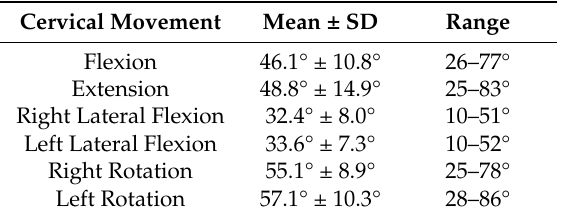
Table 5. Descriptive statistics for CROM ( n = 55, healthy subjects, optoelectronic device